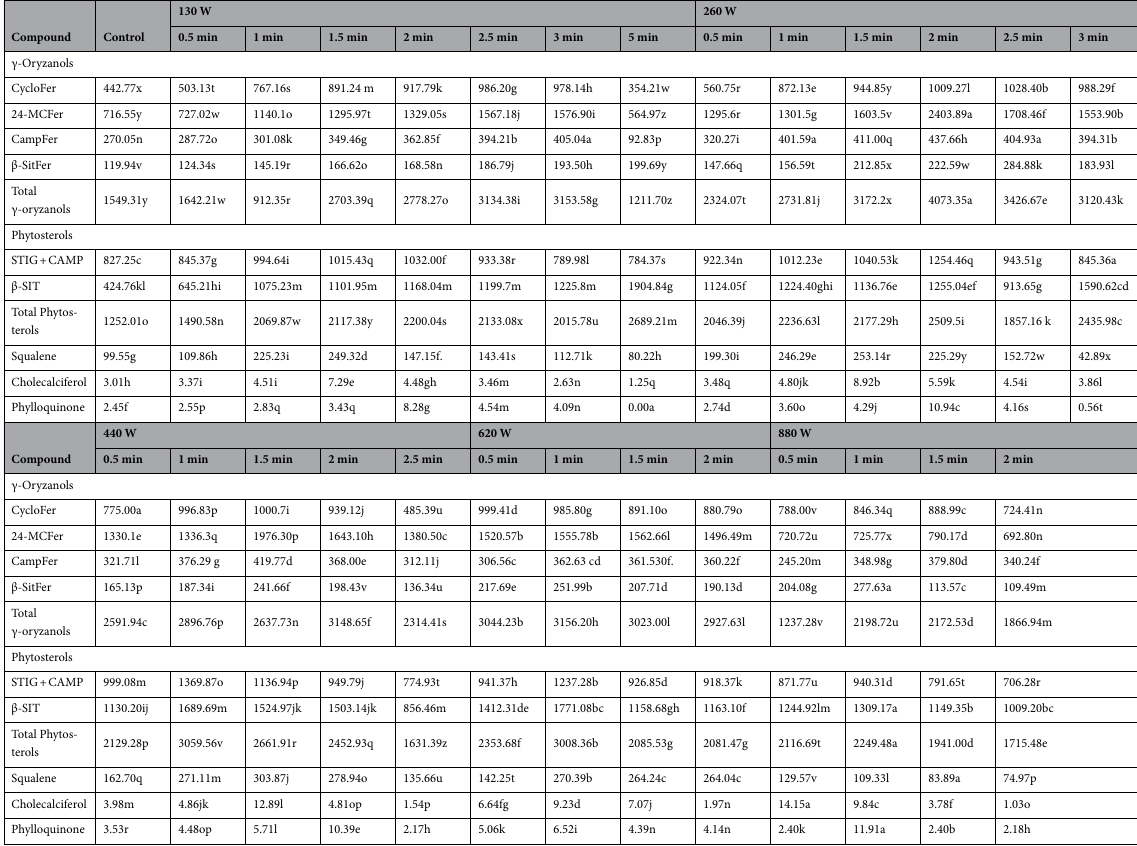
Table 4. Content of γ-oryzanols, phytosterols, squalene, cholecalciferol and phylloquinone of rice bran treated in microwave oven (µg/g). Values are means ± standard deviations ( n =